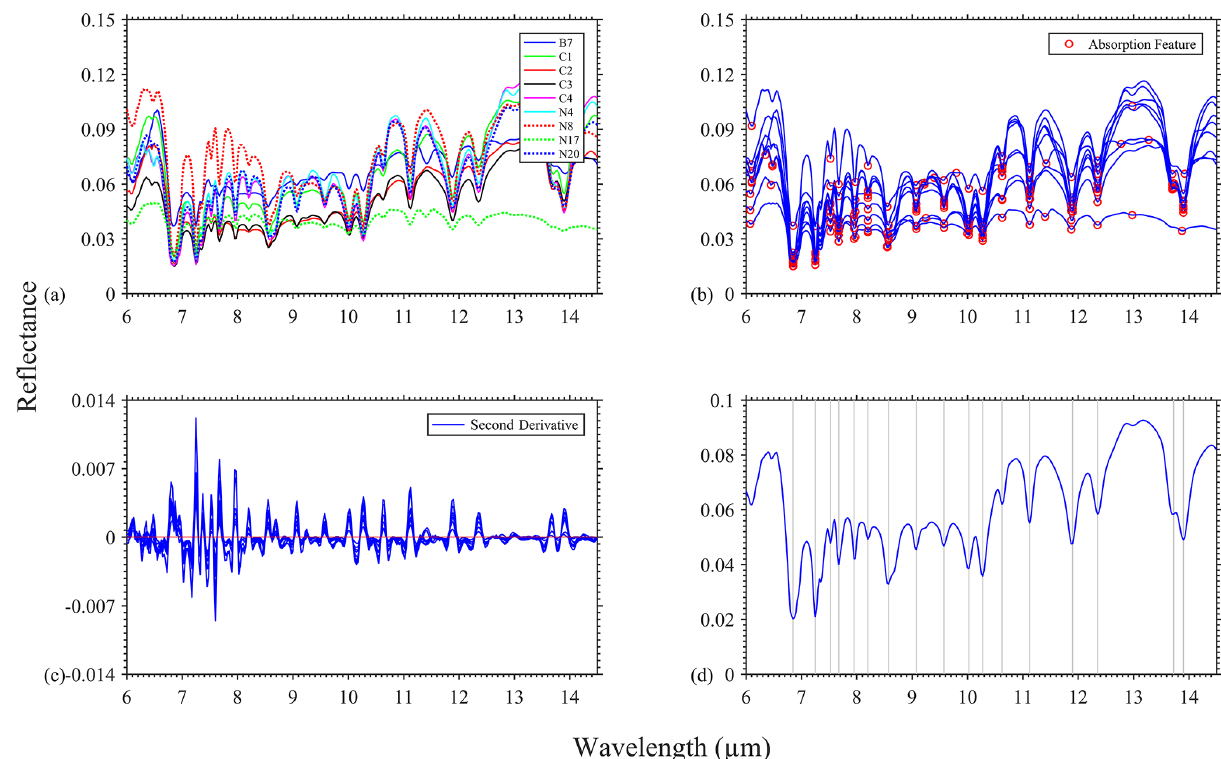
Figure 6. (a) Spectral reflectance of nautical ropes and straps found on the shorelines of Punta Mallil-Cuem, Detif and Punta Apabón on the Chiloé Archipelago, Chile; (b) absorption features automatically picked; (c) second-derivative spectra; and (d) an end-member signal with the proposed diagnostic absorption features highlighted by the vertical